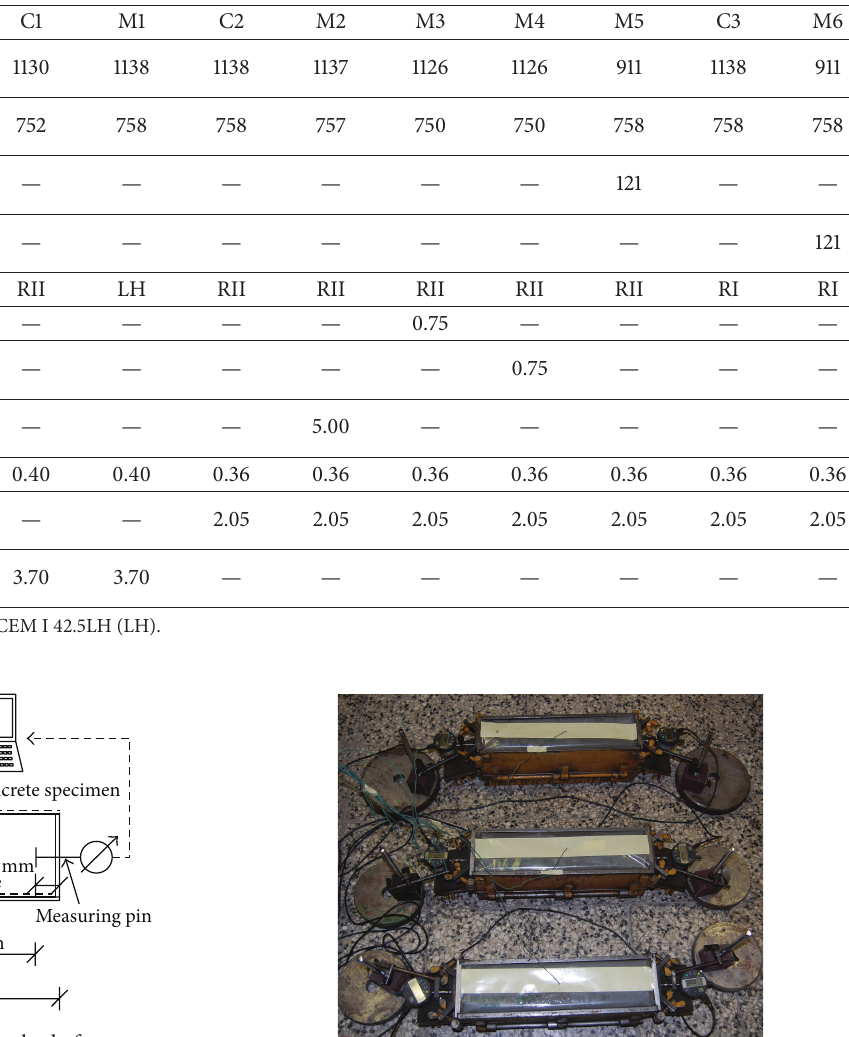
Figure 3: Schematic representation of the method of measurement of test specimen shrinkage.